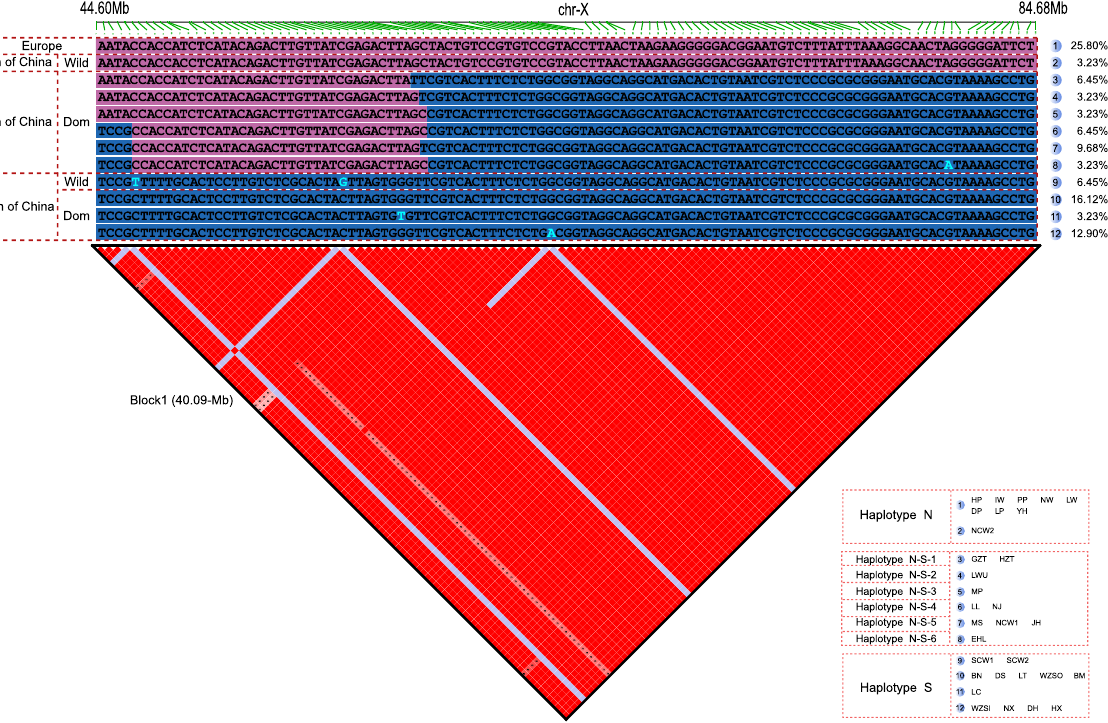
Figure 2. Haplotype pattern of LD block region on the chromosome X (1 SNP/0.3 Mb). Purple and blue represent the same or opposite alleles in the Wuzhishan reference genome, respectively. The percentages on the right are the proportions of samples with corresponding haplotypes in the total sample (n = 31). Red blocks represent LD blocks in the 40.09 Mb region. Haplotype S is identified in South China (domestic pigs and wild boars) (blue regions). Haplotype N is identified in European (domestic pigs and wild boars) as well as wild boar of North China (purple regions). Six derived Haplotypes (Haplotype N-S-1-6) are identified in domestic pigs of North China (purple and blue